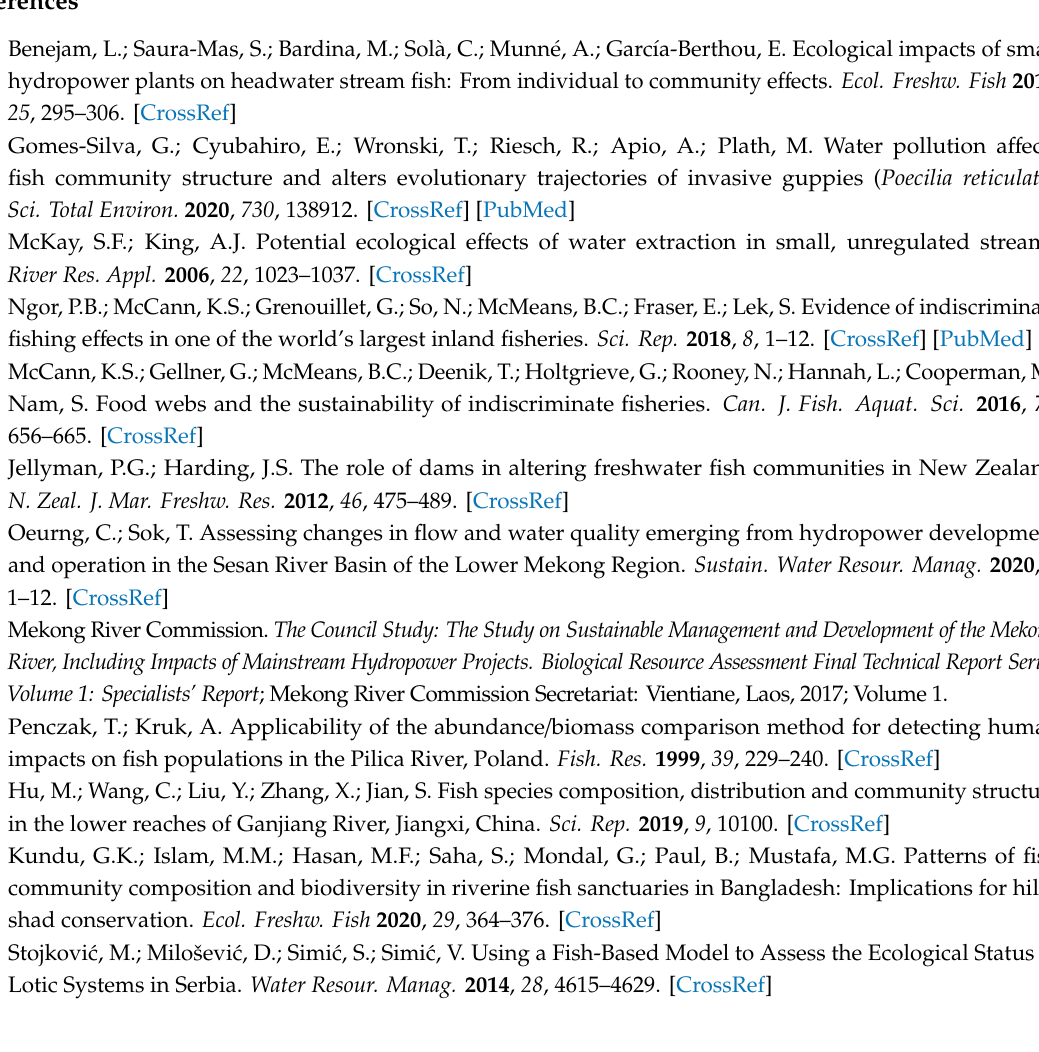
Figure S1: Sampling e ff ort at 25 sites from 2007 to 2018. Figure S2: Top ten dominant species for years with a significant LCBD index. Figure S3: Fish relative abundance categorized by fish-bodied size per group. Figure S4: Distribution patterns of 119 indicator fish species on the SOM map. Table S1: Fish species in their ecologically distinct groups. Table S2: Beta diversity, LCBD indices per year and p -values (after 999 random permutations) of SOM groups and subgroups. Table S3: Indicator species identified for each SOM group in the